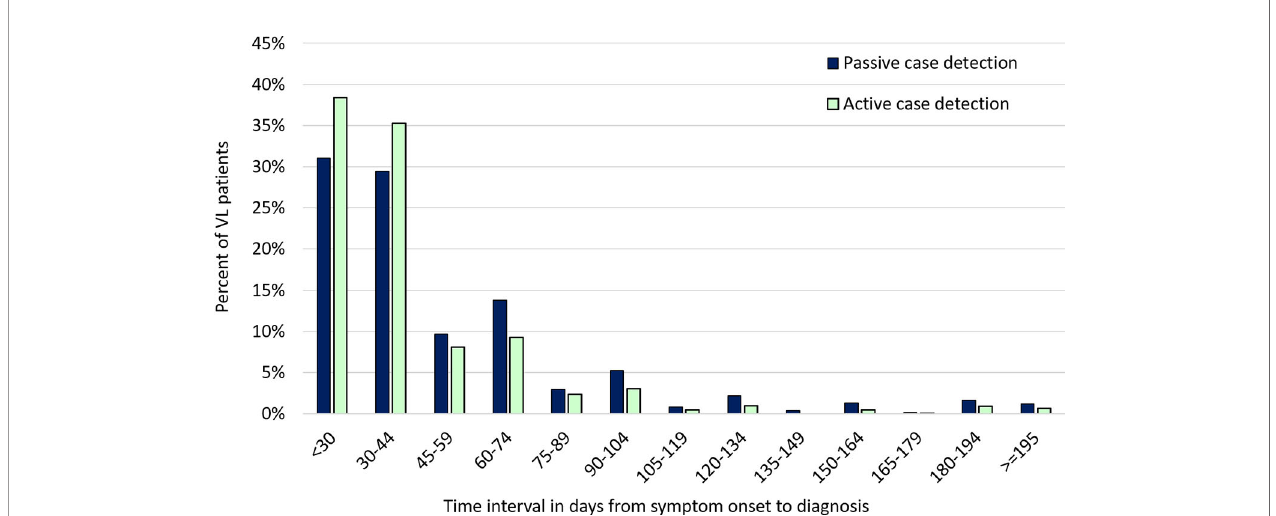
FIGURE 6 | Distribution of symptom duration prior to diagnosis among visceral leishmaniasis patients identi fi ed by active versus passive case detection, January 1, 2018 - July 31, 2019. The fi gure shows the percentage of VL cases falling into each category of duration in days from fever onset to diagnosis. The distribution of VL patients identi fi ed by active case detection (ACD; in pale green) is shifted toward shorter duration categories compared to that for patients identi fi ed by passive case detection (PCD; in blue). The distribution has a very long right-hand tail, with a small percentage of patients having durations longer than 6 months; PCD predominates over ACD in the longer duration categories. The analysis includes 5030 patients reported to the Kala-azar Management Information System (KAMIS) during the time